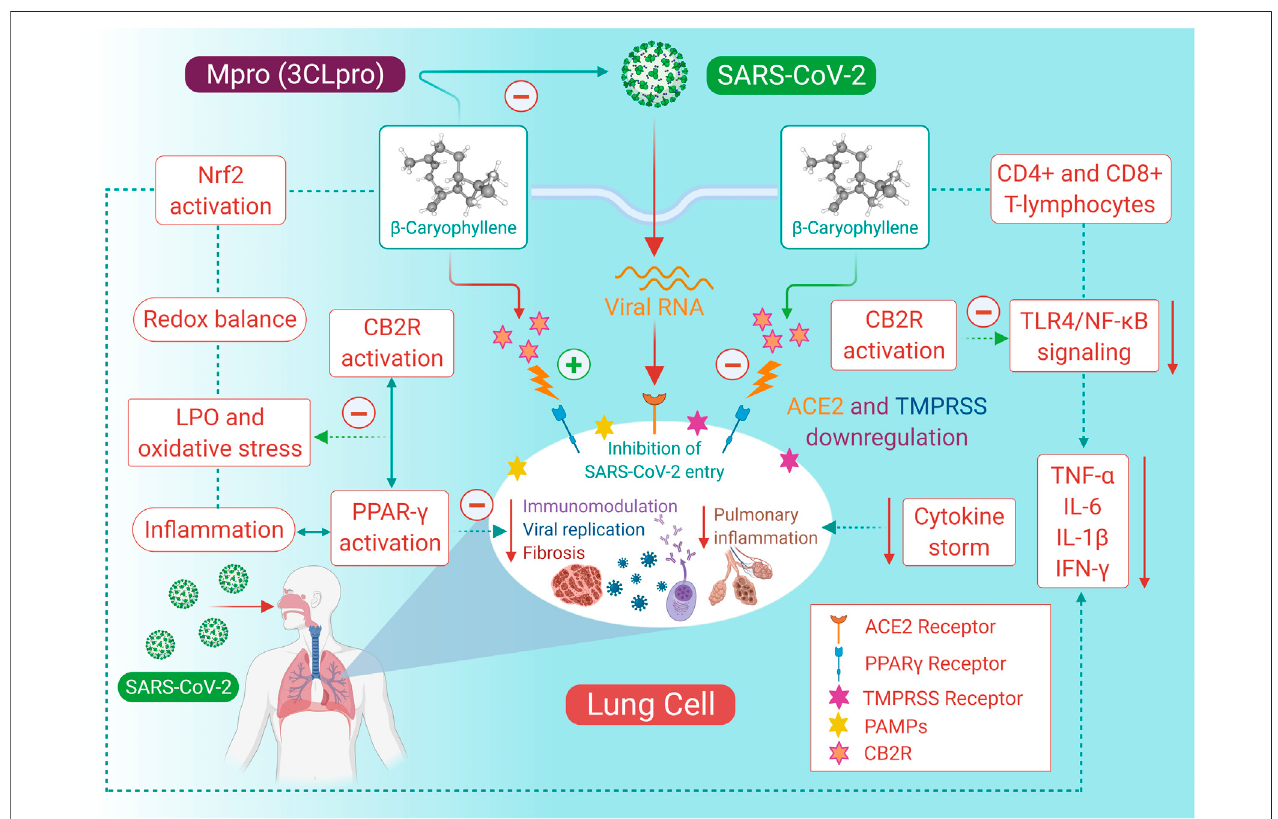
FIGURE 2 | The proposed possible mechanisms and potential of BCP in